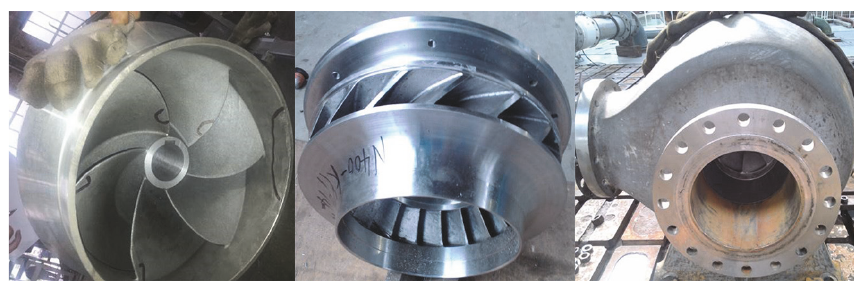
Figure 4: Test used